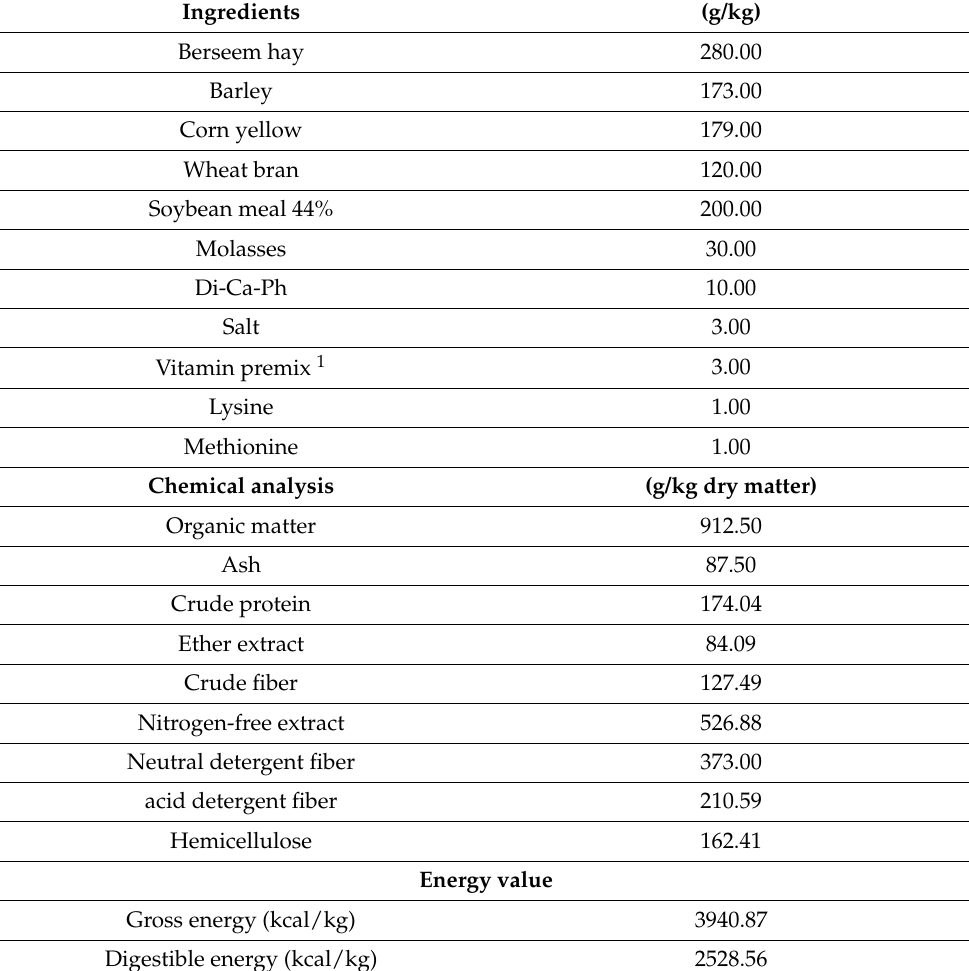
Table 1. The ingredients and chemical analysis of the experimental